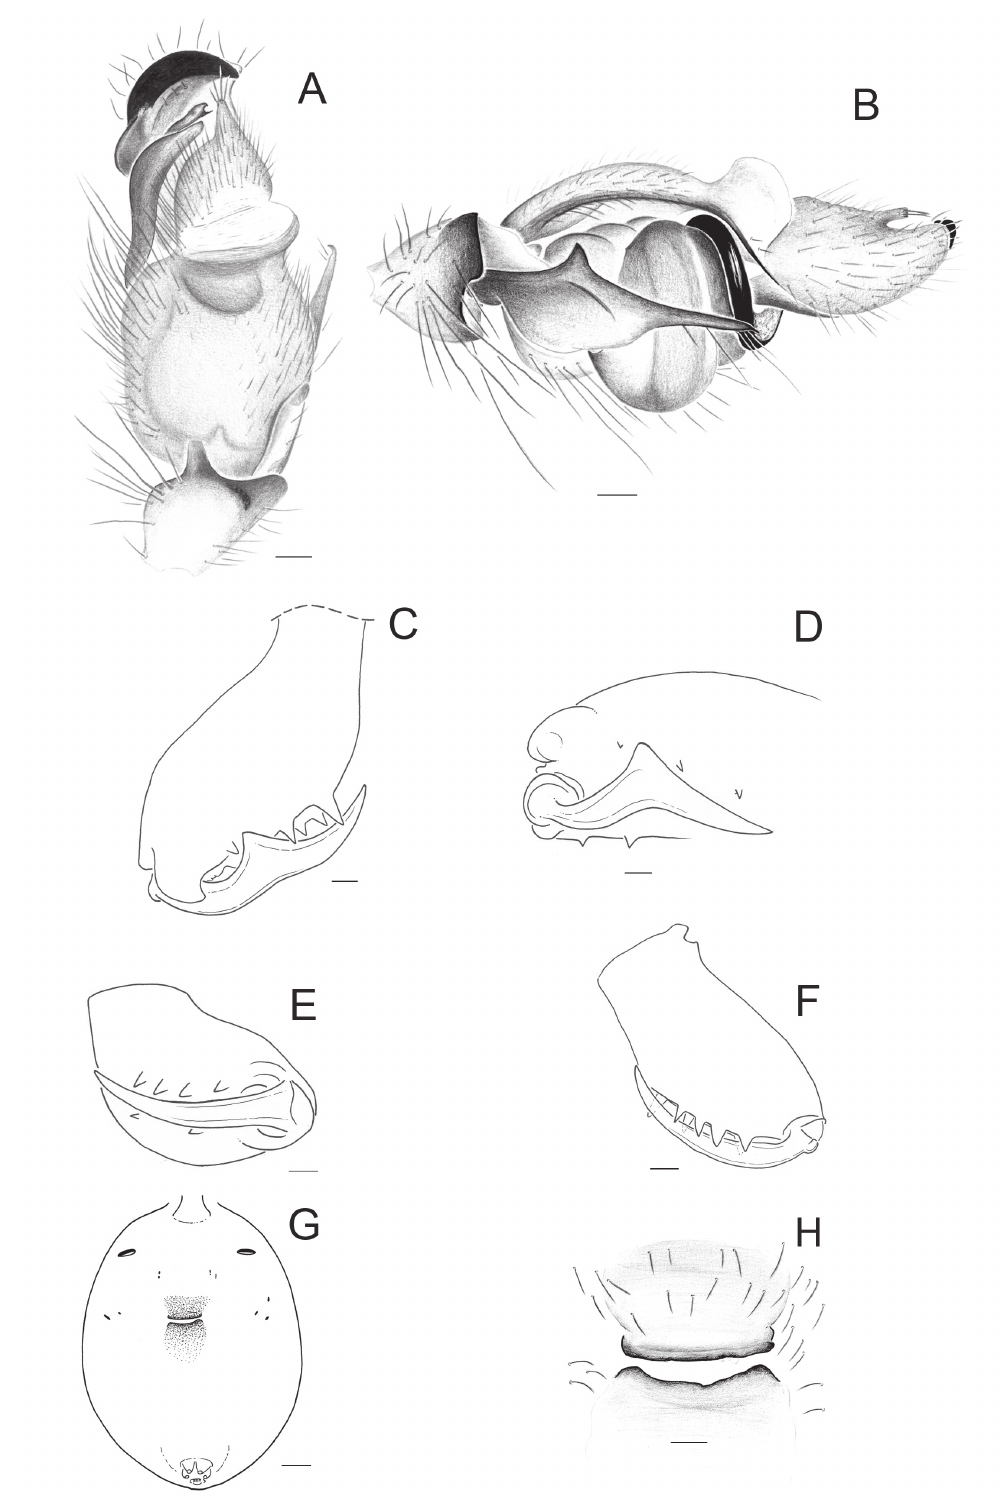
Fig. 3. Pachygnatha intermedia sp. nov. A . Male palp, ventral view. B . Male palp, retrolateral view. C . Male chelicera, frontal view. D . Male chelicera, ventral view. E . Female chelicera, ventral view. F . Female chelicera, frontal view. G . Female abdomen, ventral view. H . Female external genitalia, ventral view. Scale bars: a–F, h = 0.1 mm; g = 1